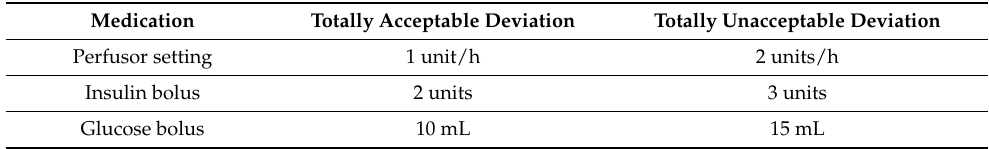
Table 3. Thresholds for accepted and non-accepted deviations.